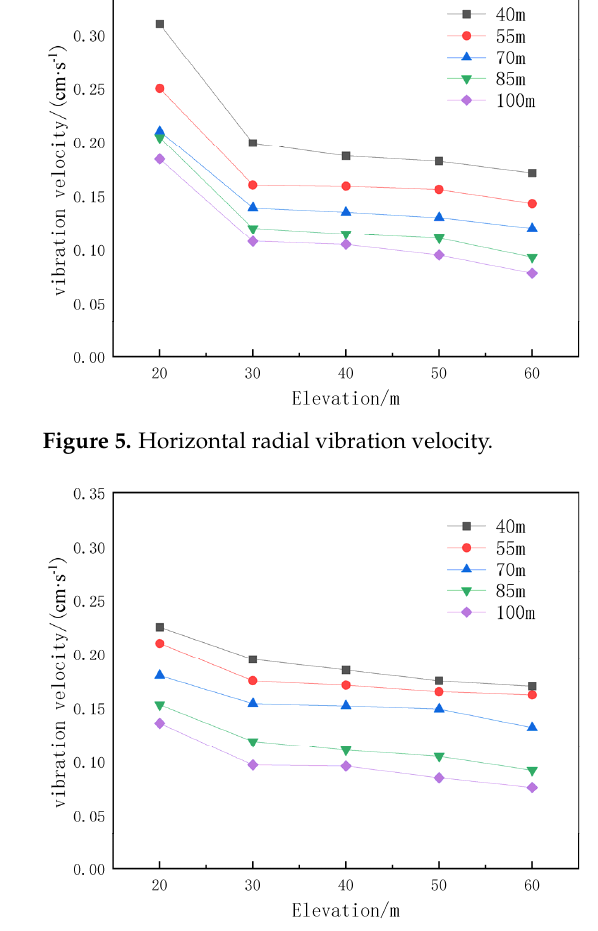
Figure 6. Horizontal tangent vibration velocity.